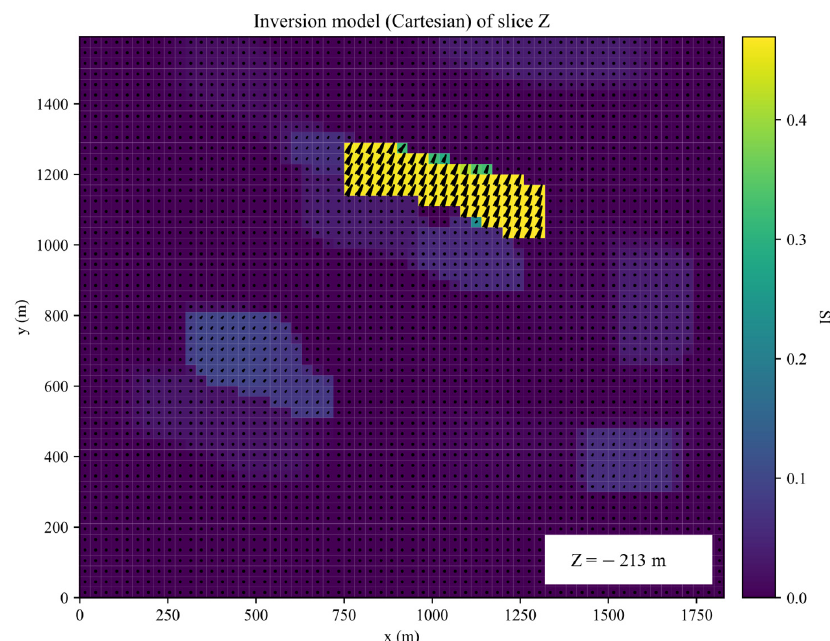
Figure 15. Slices along the Z planes of inverted Galinge iron ore deposit.